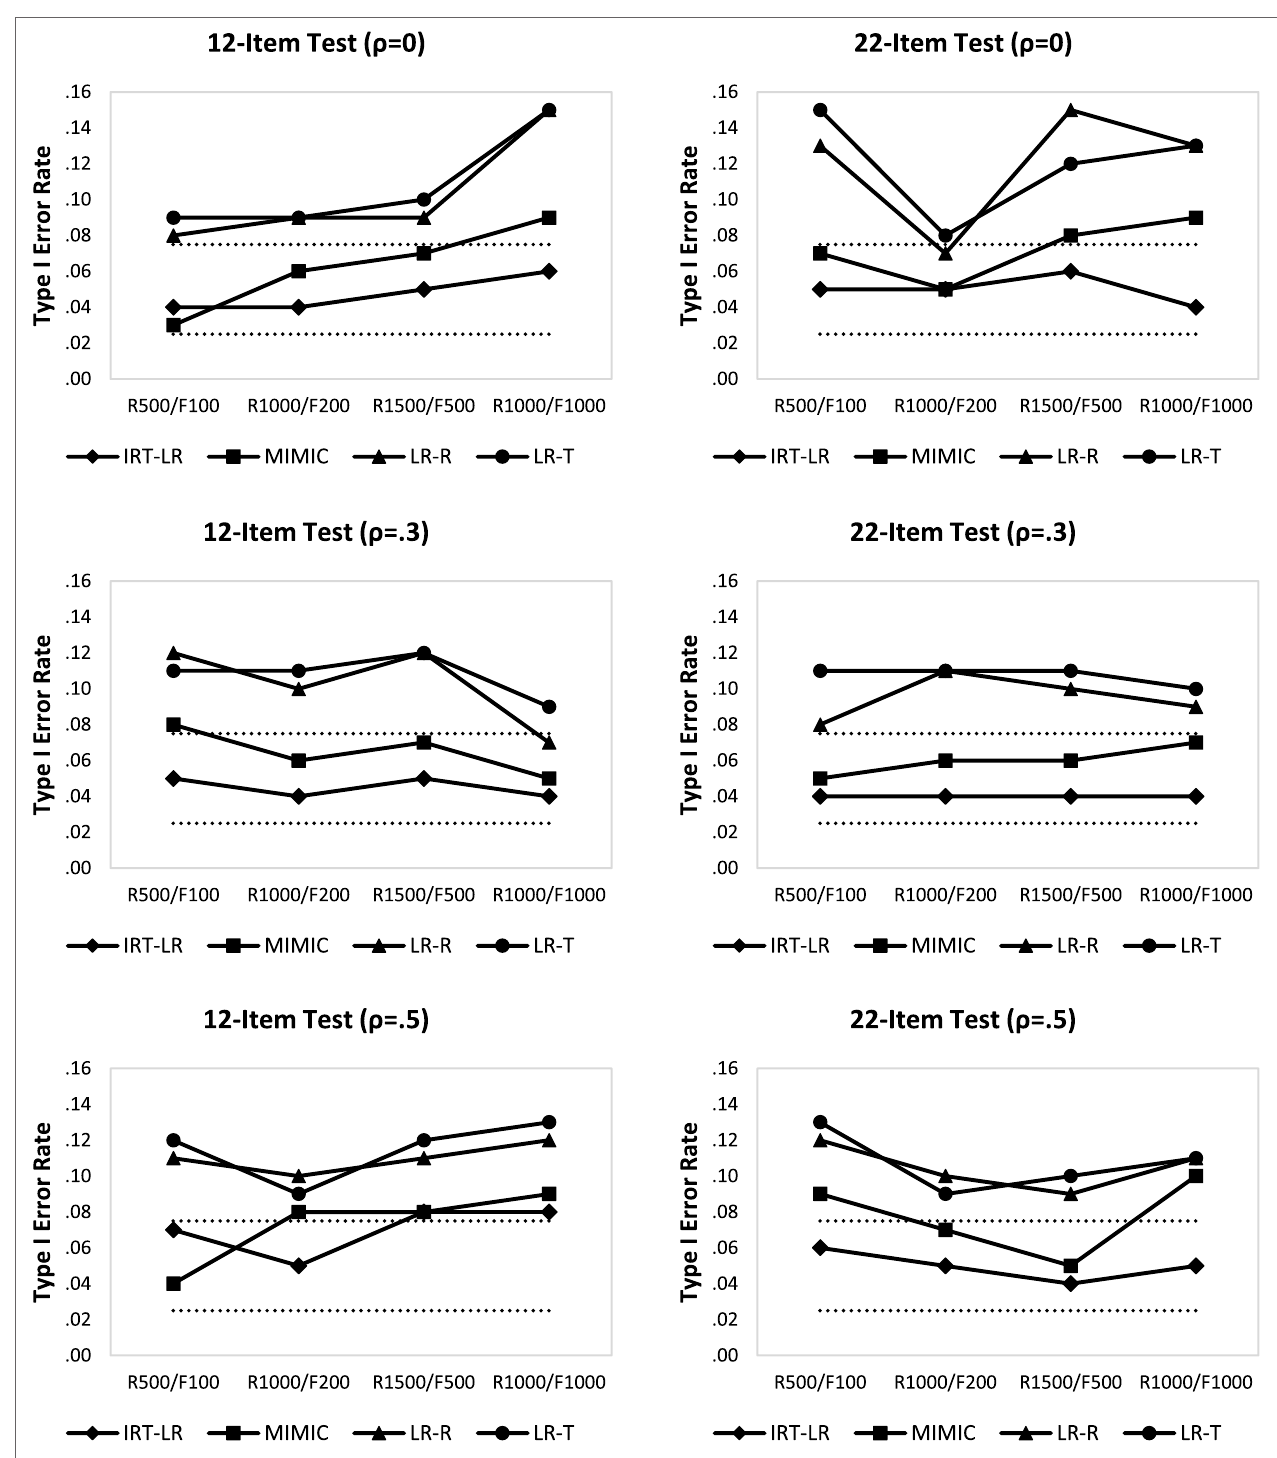
FIGURe 1 | Type I error rates in the 12-item and 22-item tests ( note : dotted lines indicate Bradley’s liberal robustness criteria; LR-R is logistic regression with raw scores; and LR-T is logistic regression with latent trait scores).